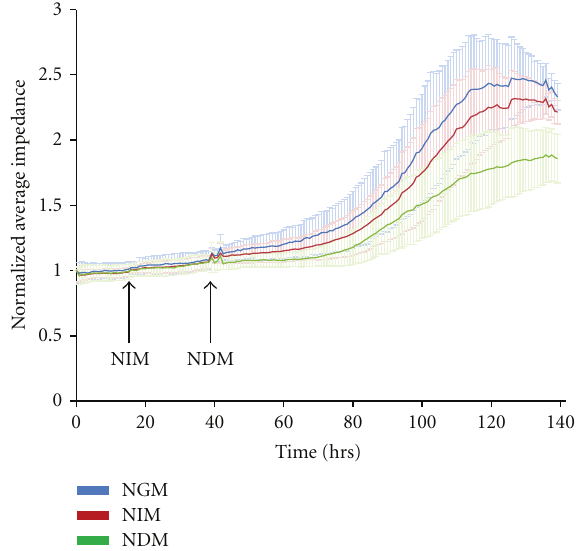
Figure 4: Resistance monitoring of hMSC layers during the cultivation with or without the neural di ff erentiation factor. The resistances of cells were measured every 5 min with an input current of 1 μ A at 16kHz, and the average of normalized resistances was displayed. Arrows indicate the time points of media change. Error bar are indicating the standard deviation of the three di ff erent experiment (NGM: normal growth media, n = 5; NIM: neural induction media, n = 9; NDM: neural di ff erentiation media, n =